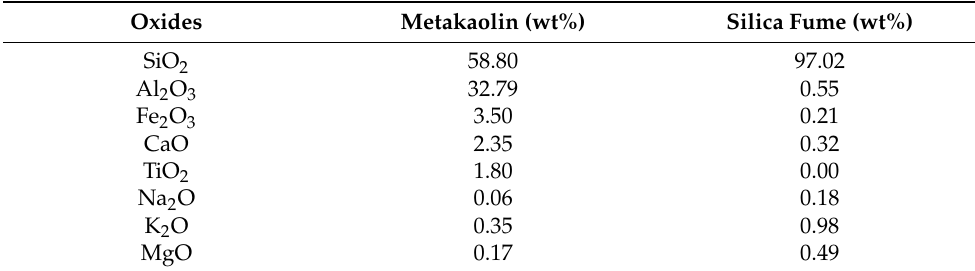
Table 1. Chemical composition (wt%) of metakaolin and silica fume.